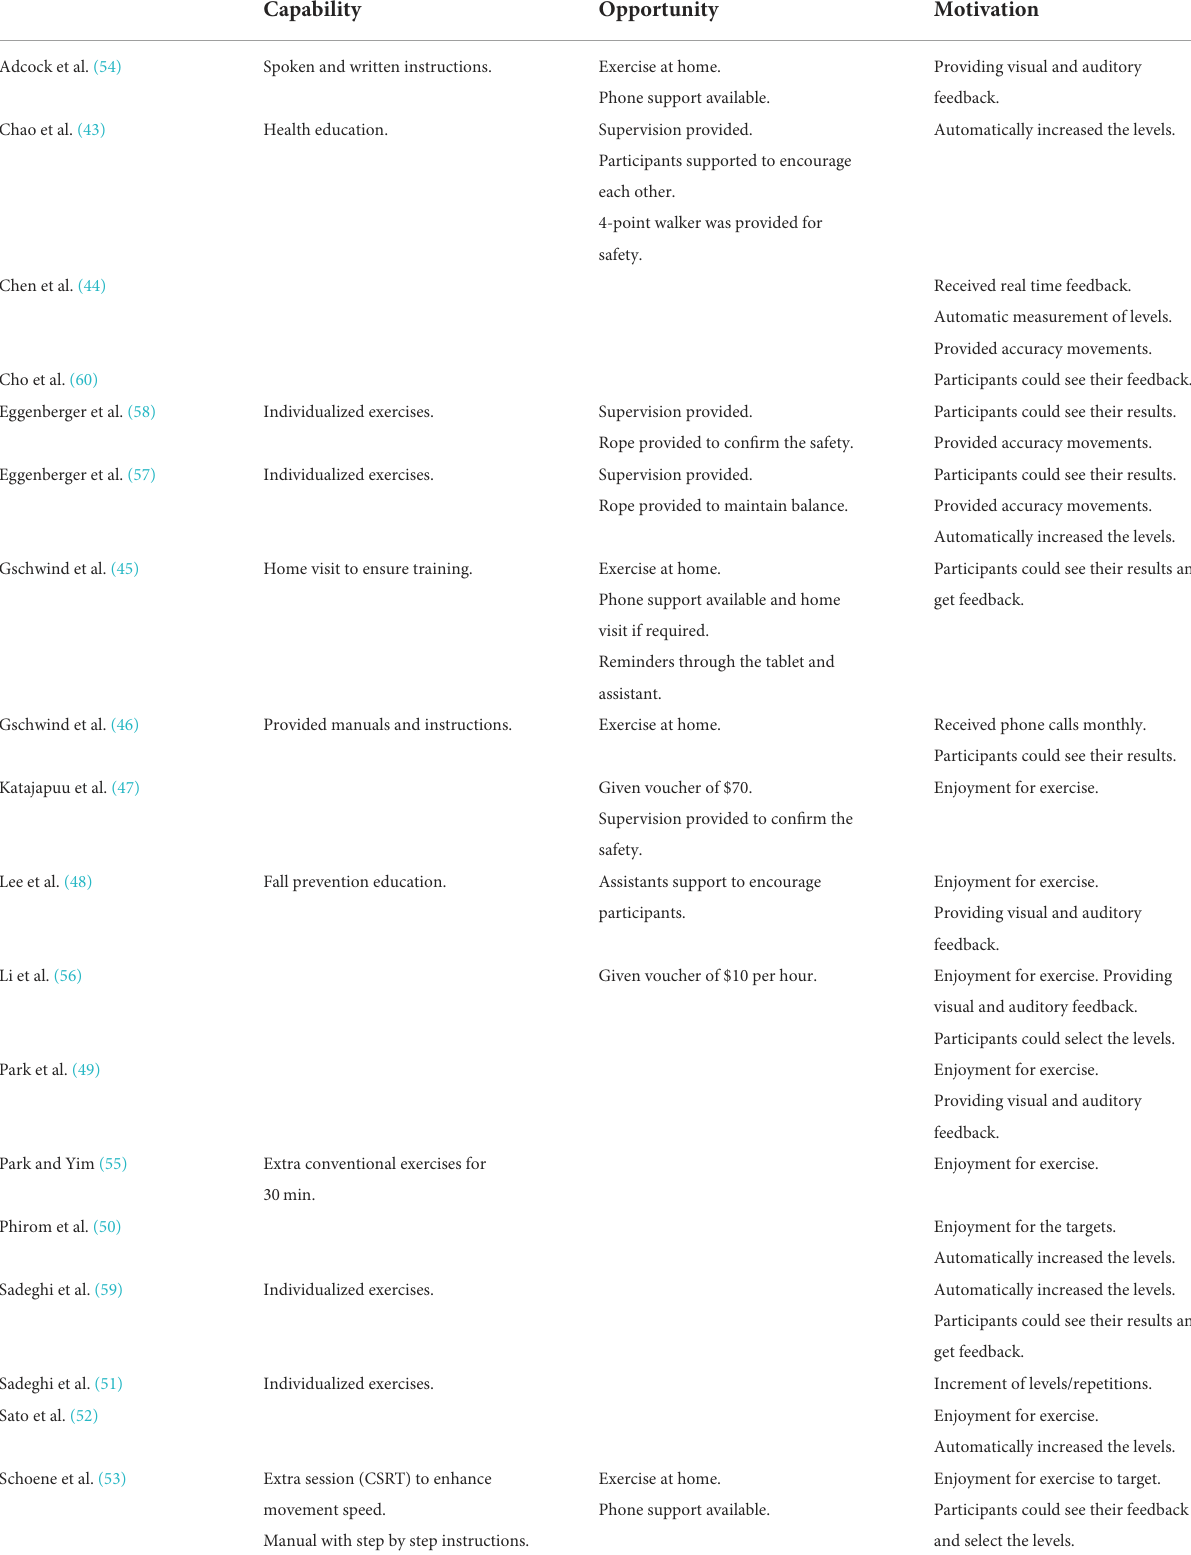
TABLE 2 Elements of motivation identified using the COM-B